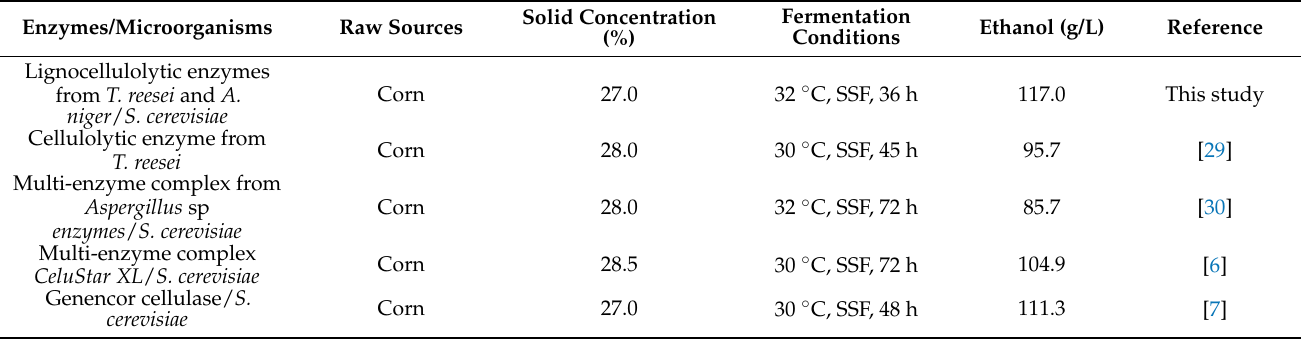
Table 5. Comparison alcohol yield under different fermentation